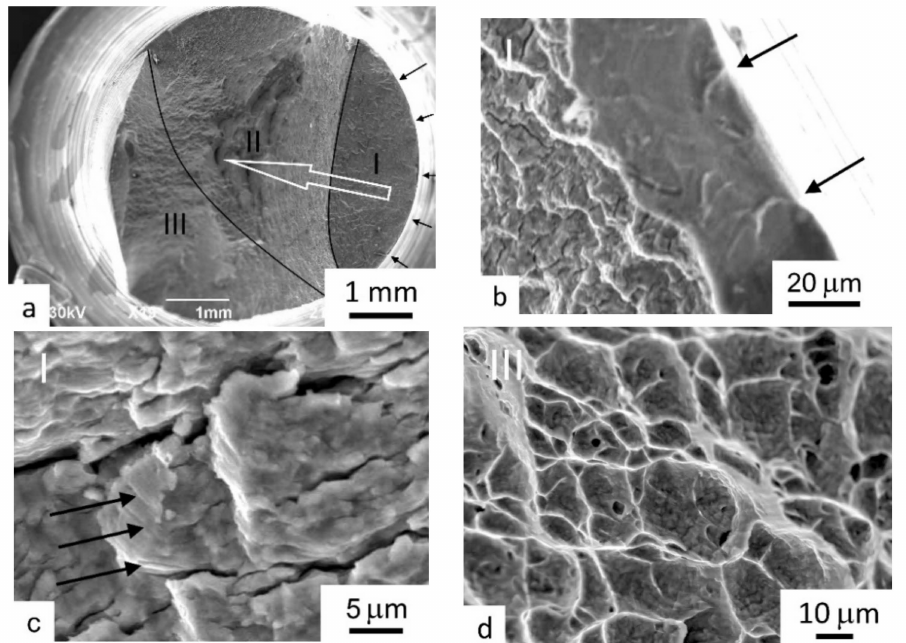
Figure 9. SEM images of the fracture surfaces of the samples after tests at a stress of 900 MPa, for the UFG alloy: ( a ) general view of the fracture surface (the black arrows show the origins and the white arrow shows the direction of growth of the main crack), ( b ) areas of shear in the zone of fatigue microcrack initiation, ( c ) zone of stable crack propagation in the UFG sample (the black arrows show the fatigue striations), ( d ) final rupture